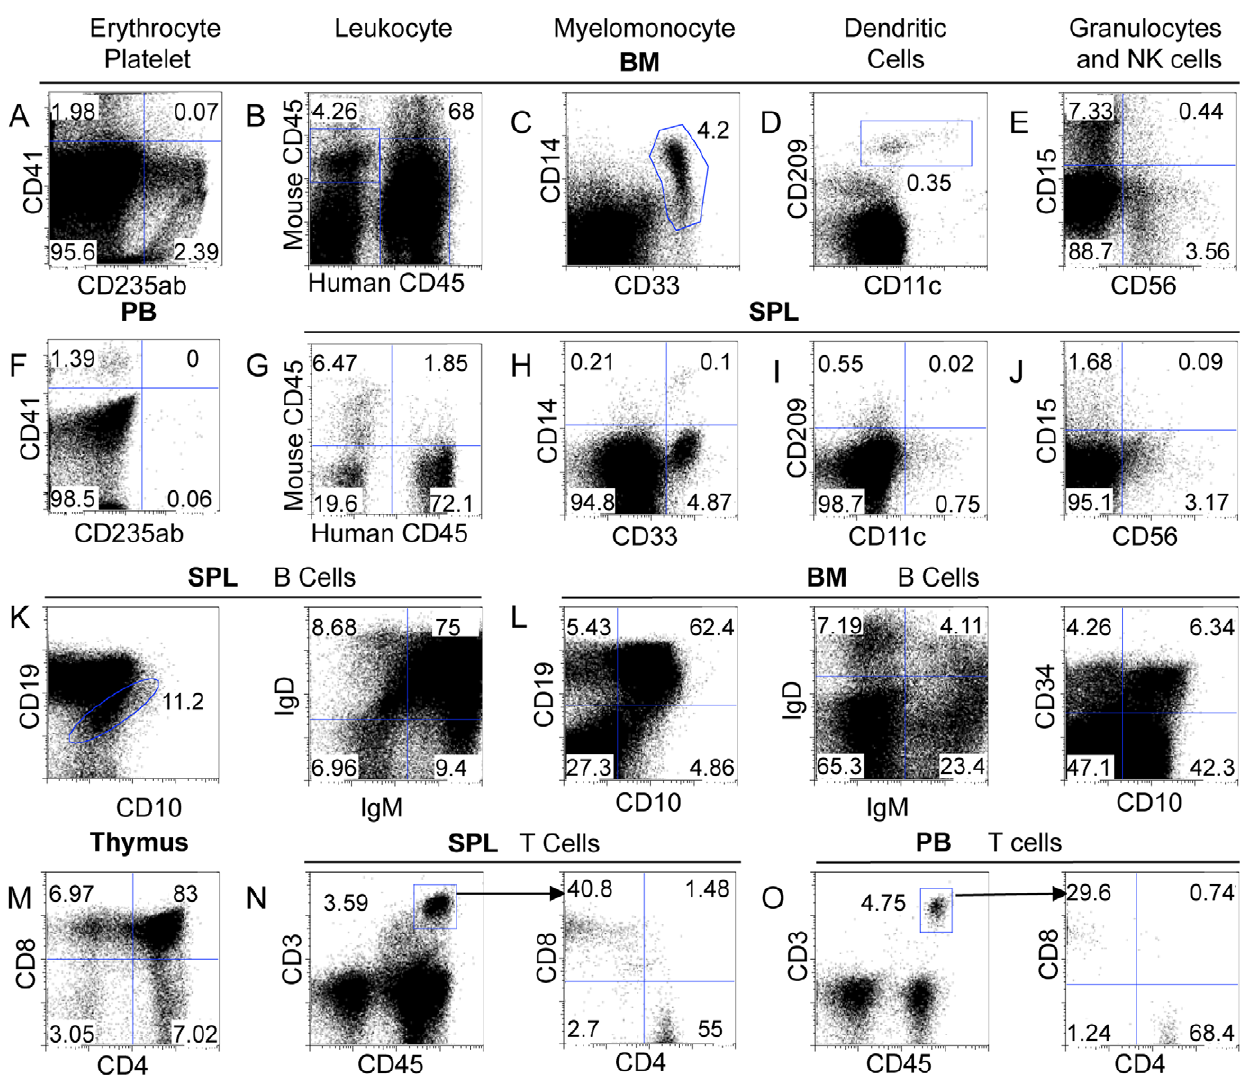
Figure 4. Multi-lineage reconstitution in adult NSG mice. Sub-lethally irradiated NSG adults were injected with 2.5–5 6 10 5 expanded CD34 + CD133 + cells. Cells in the bone marrow (A–E, L), blood (F, O), thymus (M) and spleen (G–J, K, N) were analyzed by flow cytometry 12 weeks after reconstitution. Shows are staining profiles for erythrocytes (CD235ab + ) and platelets (CD41 + ) (A and F), total leukocytes (human CD45 + ) (B and G), myelomonocytes (CD14 + CD33 + ) (C and H), dendritic cells (CD11c + CD209 + ) (D and I), granulocytes (CD15 + ) and natural killer cells (CD56 + ) (E and J), B cell stages (proB - CD34 + CD10 + , immature - CD10 + , mature - IgM + IgD + ) (K and L), T cell precursors (double negative, double positive and single positive) (M) and mature T cells (CD45 + CD3 + expressing either CD4 or CD8) (N and O). The numbers indicate percentages of cells in the gated region. Representative data from one of at least 5 mice are shown. All cells shown are gated on live human cells (FSC/SSC/live/CD45 + ) except A, F (FSC/SSC only) B, G (FSC/SSC/live) and the IgM vs IgG stains (FSC/SSC/live/CD45 + /CD19 + ). Summaries of human cell characterization can also be found in Table 2.